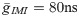
IMI counterbalances leak conductance to rescue neural oscillations in a computational model.(A) Model output of LG membrane potential at (i) low leak and IMI conductance (g
leak = 20 nS, g¯IMI=80 ns), (ii) increased leak (g
leak = 40 nS, g¯IMI=80 ns), and (iii) increased IMI (g
leak = 40 nS, g¯IMI=120 ns). Vertical scale bars, 20 mV. (B) Color map of number of bursts occurring in 100 s for 1,100 simulations as a function of leak and IMI conductances. Warmer colors represent more bursts;* highlights areas with one burst. (C) Color map of the number of LG spikes/100 s for 1,100 simulations as a function of leak and IMI conductances. Warmer colors represent more LG spikes. (B–C) Labeled areas (i–iii) indicate parameter sets corresponding to the traces shown in A.